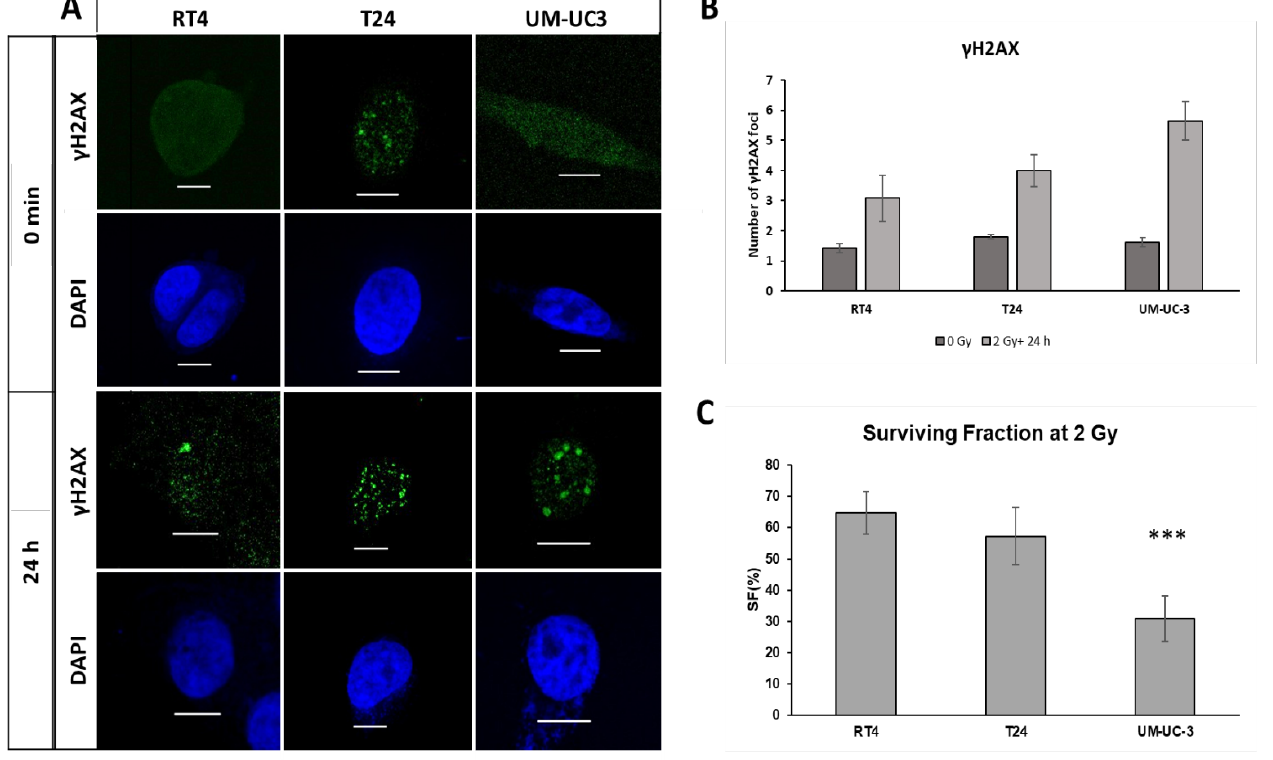
Figure 2. Radiosensitivity of RT4, T24 and UM-UC-3 in 2D. ( A ) Immunofluorescence (IF) imaging of ɣ H2AX and DAPI for the three cell lines RT4, T24 and UM-UC3 at without irradiation and 24 h after a 2 Gy treatment (scale bar = 5 μm). ( B , C ) Histogram of the average number of ɣ H2AX foci for RT4, T24 and UM-UC3 at 0 min and 24 h post-treatment. Results are represented as the mean of 3 independent experiments ± SEM. Each experiment was repeated 3 times and the number of foci was counted in 30 nuclei per experiment. Mann-Whitney-Wilcoxon tests were performed for statistical significance (*** p < 0.001) .